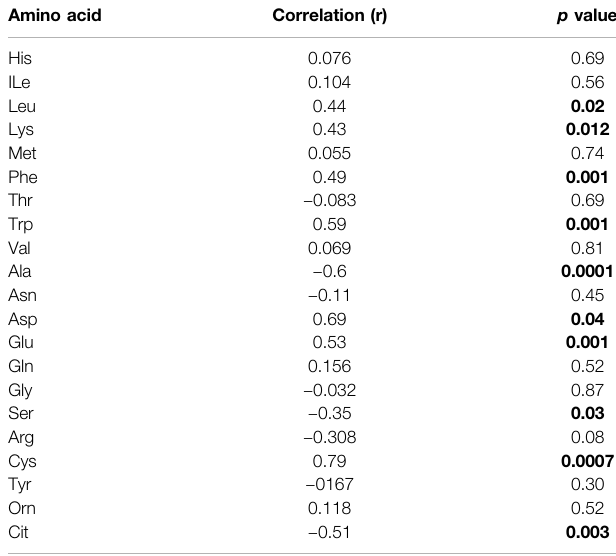
The bold values indicate statistically signi fi cant values. TABLE 4 | Correlation analysis between duration of metformin treatment and amino acids concentrations in T2D. Amino acid